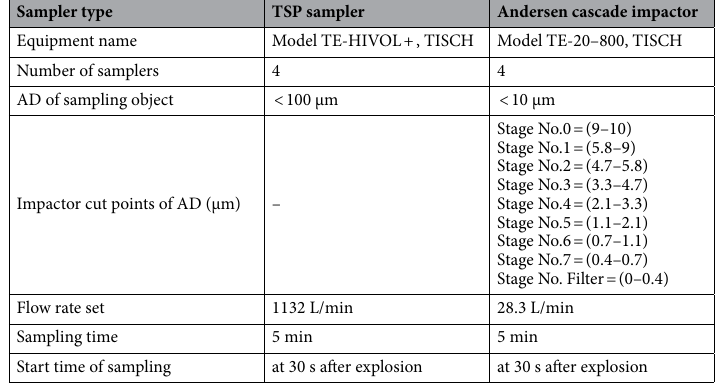
Table 3. Run parameters for the samplers used in the experiment.